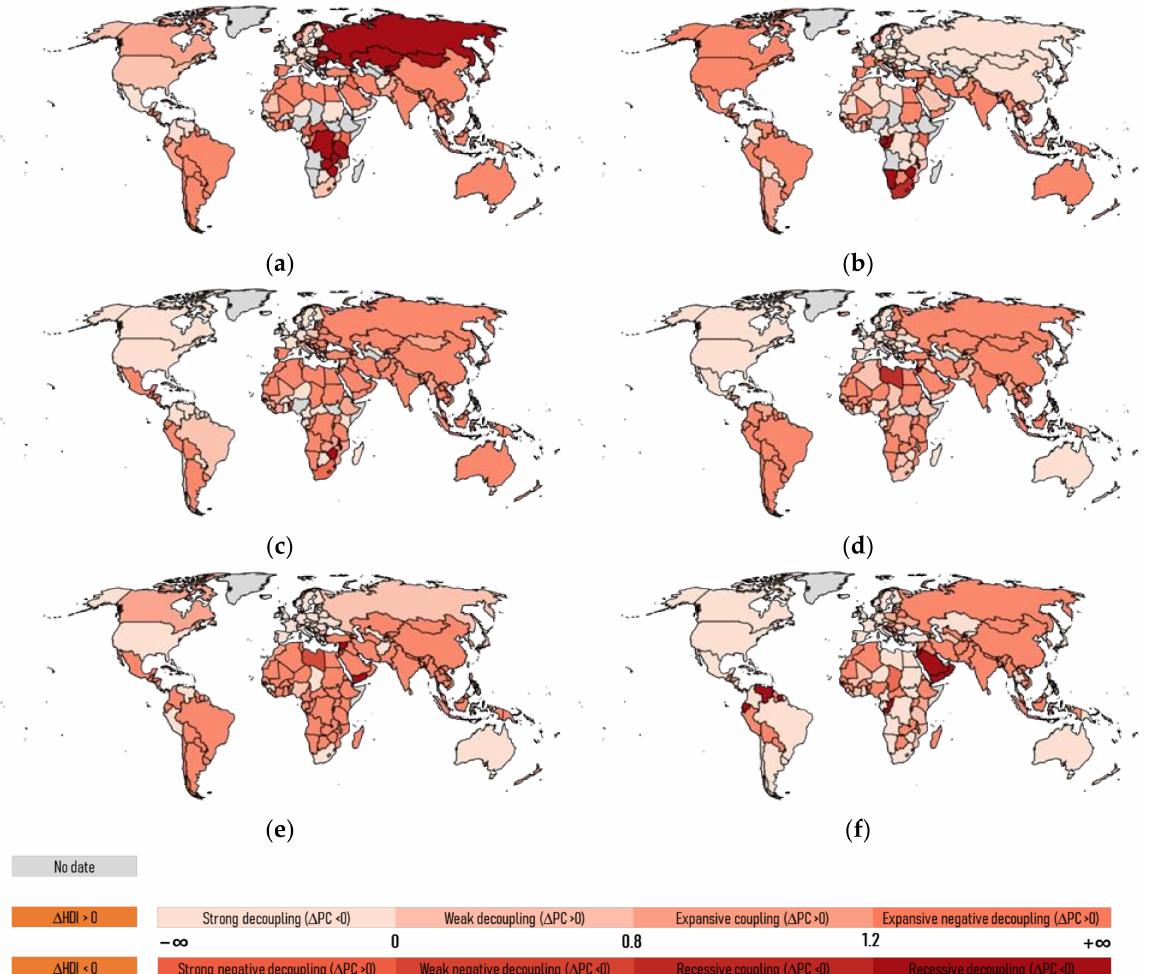
Figure 3. Spatial distribution of the decoupling index over six periods. Source: Authors’ own construction using Excel. ( a ) 1990–1995; ( b ) 1995–2000; ( c ) 2000–2005; ( d ) 2005–2010; ( e ) 2010–2015; ( f )